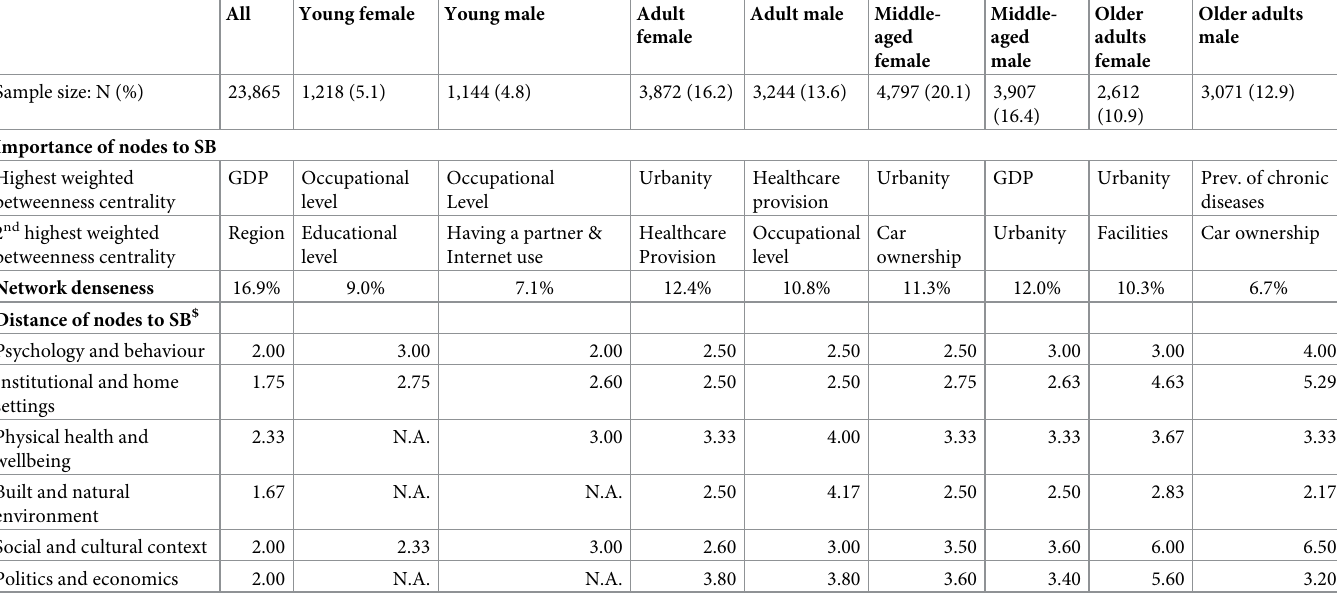
Table 1. Sample size and network statistics determining most important nodes by means of weighted betweenness centrality, network denseness and unweighted distance to the factor sedentary behaviour (SB) calculated for the complete sample from the Eurobarometer and for each sex- and age-stratum.